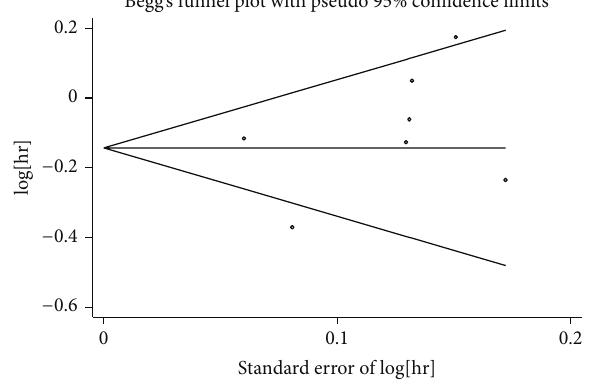
Figure 6: Funnel plot for publication bias test OS. The two oblique lines indicate the pseudo 95% confidence limits.